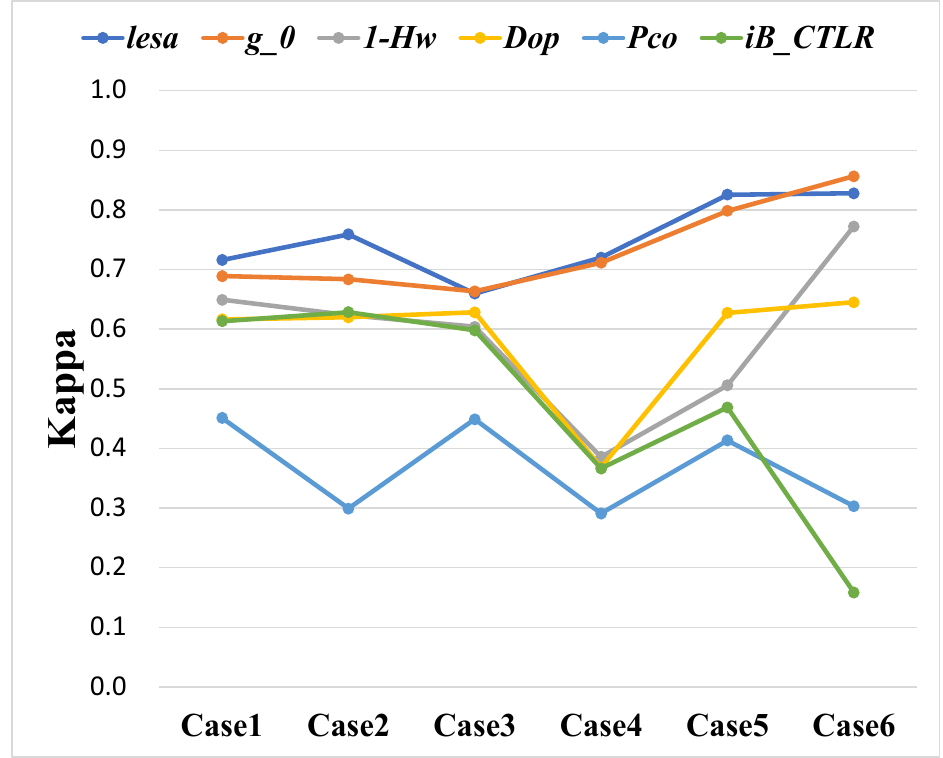
Figure 20. Kappa accuracy of random forest classification for six polarized features in six cases.